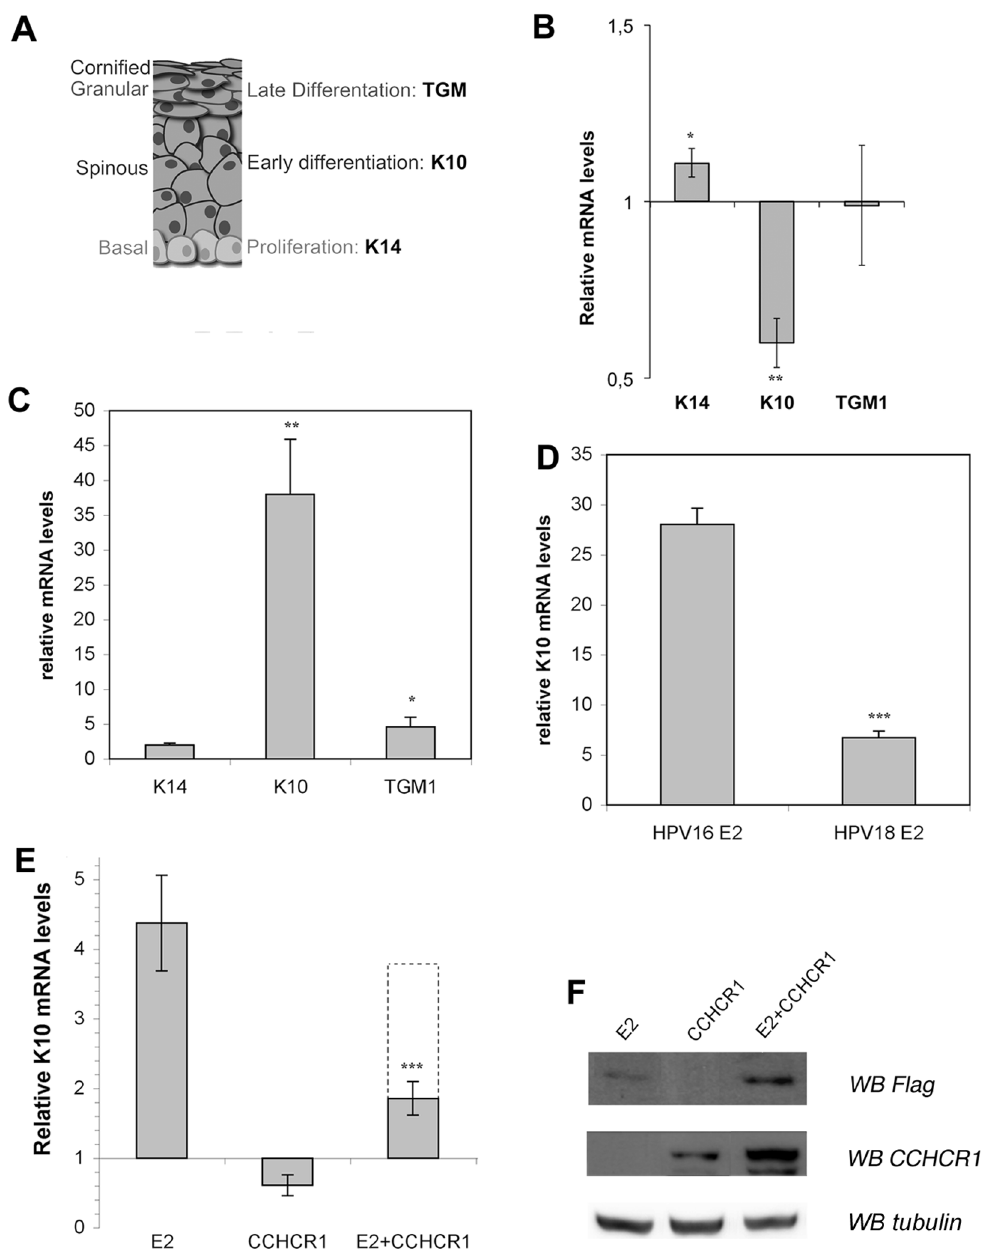
Figure 3. CCHCR1 inhibits the activation of early differentiation by HPV16 E2. (A) Schematic representation of the differentiation of a keratinized epithelium, with studied markers outlined. (B) HaCaT cells were transfected by a CCHCR1 expression plasmid, and the mRNA levels of three differentiation markers were subsequently monitored by qRT-PCR. Results are represented as relative to mock- transfected cells (empty plasmid). *, p , 0.05; **, p , 0.01 versus mock-transfected cell experiments. (C) HaCaT cells were infected by Ad-GFP16E2 and the mRNA levels of three differentiation markers were subsequently monitored by qRT-PCR. Results are represented as relative to cells infected with Ad-GFP. *, p , 0.05; **, p , 0.01 versus cells infected with Ad-GFP. (D) HaCaT cells were infected by Ad-GFP16E2 or Ad-GFP18E2 and mRNA levels of K10 were subsequently monitored by qRT-PCR. Results are represented as relative to Ad-GFP expressing cells. ***, p , 0.001 versus cells infected with Ad-GFP16E2. (E) HaCaT cells were transfected by 3XFLAG-HPV16 E2 and CCHCR1 expression plasmids as indicated and the subsequent effect of the mRNA levels of K10 was monitored by qRT-PCR. Results are represented relative to mock-transfected cells. The dotted line represents the K10 mRNA levels expected by simply combining the levels obtained in the presence of each E2 and CCHCR1 protein separately. ***, p , 0.001 versus cells infected with HPV16 E2 only. (F) HaCaT cells were transfected as in (E) and western blots were performed on total cell lysate with anti FLAG or anti CCHCR1 antibodies, then with anti- tubulin antibody as loading control. fused to GFP and CCHCR1 fused to mCherry were transiently CCHCR1 relocalizes HPV16 E2 into the cytoplasm expressed in HaCaT cells (Fig. 4). The fluorescence revealed that To get further insights into how CCHCR1 impacts on HPV16 the expression pattern of CCHCR1 consists in punctuated signals E2 functions, we conducted fluorescent studies where HPV16 E2